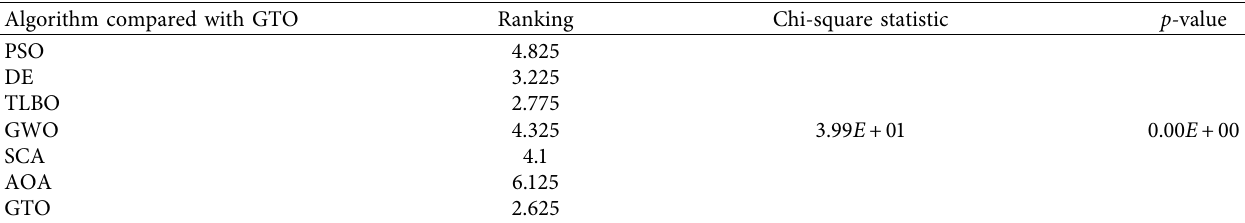
Table 12: Friedman test for the multiple comparison between GTO and its peer algorithms. Algorithm compared with GTO Ranking